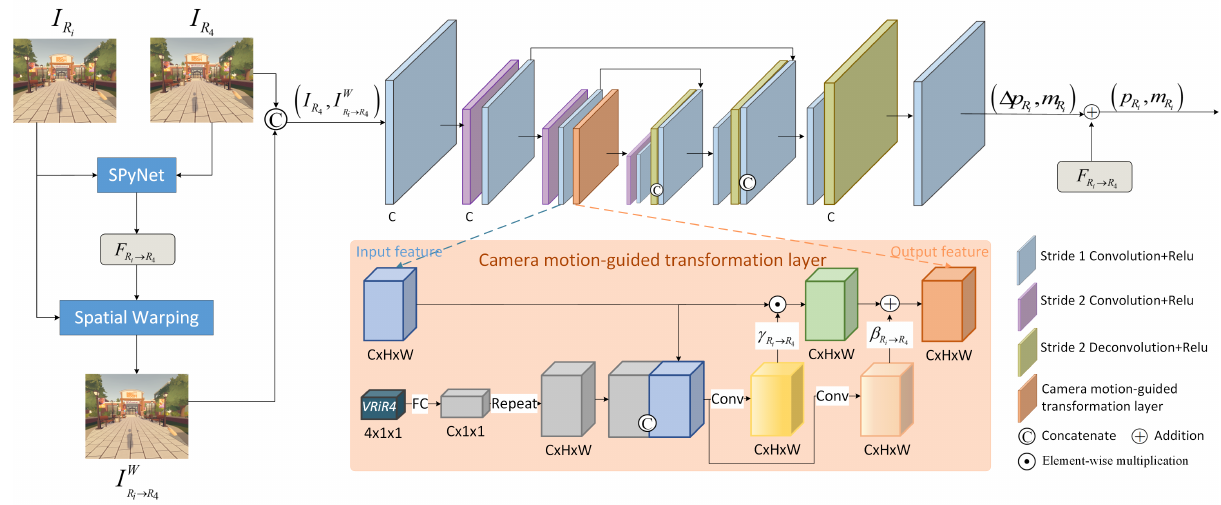
Figure 4. Illustration of the CMGP